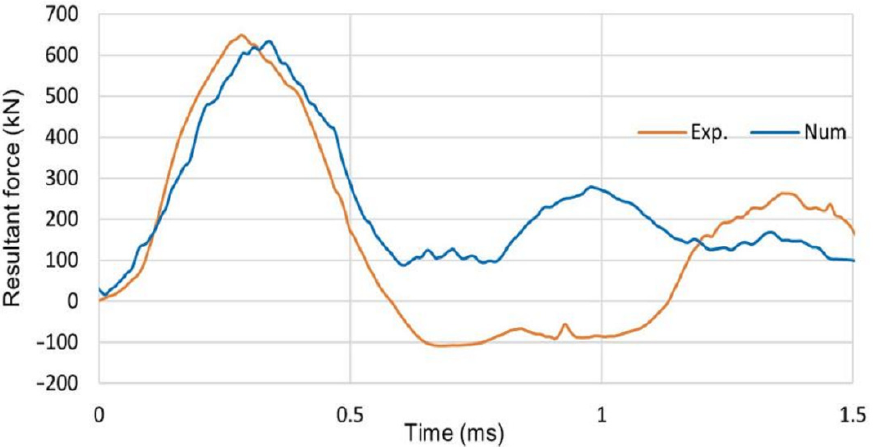
Figure 31. Comparison of the resultant forces obtained from experimental and numerical analyses (shot no. 9).